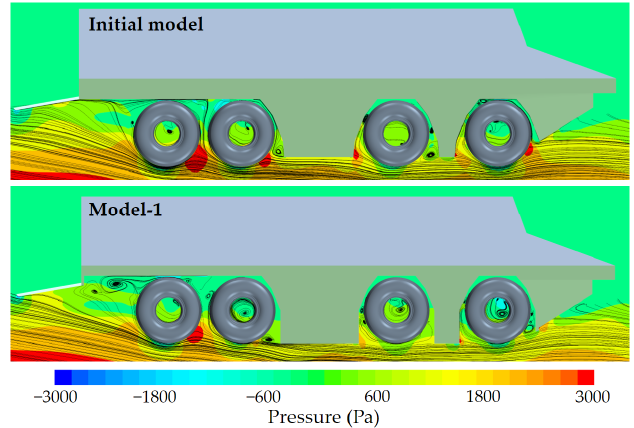
Figure 19. Comparison of the streamline and pressure distribution of the wheel longitudinal section of the initial model and the Model-1 at Fr = 0.624.